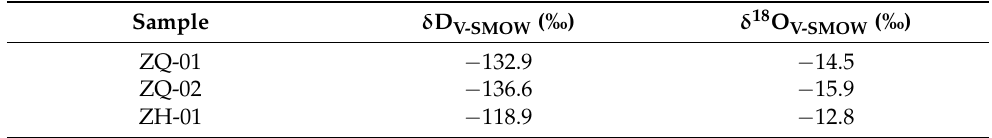
Table 2. Hydrogen and oxygen isotope data of Zabuye water